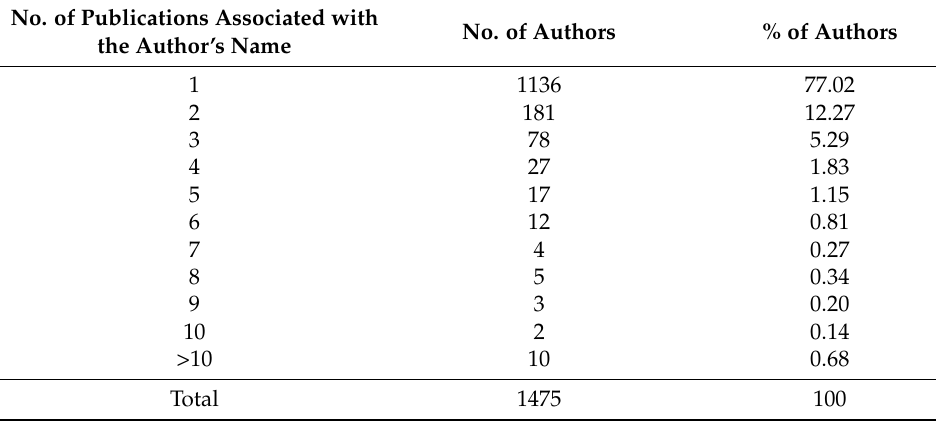
Table 18. Number of publications by author.